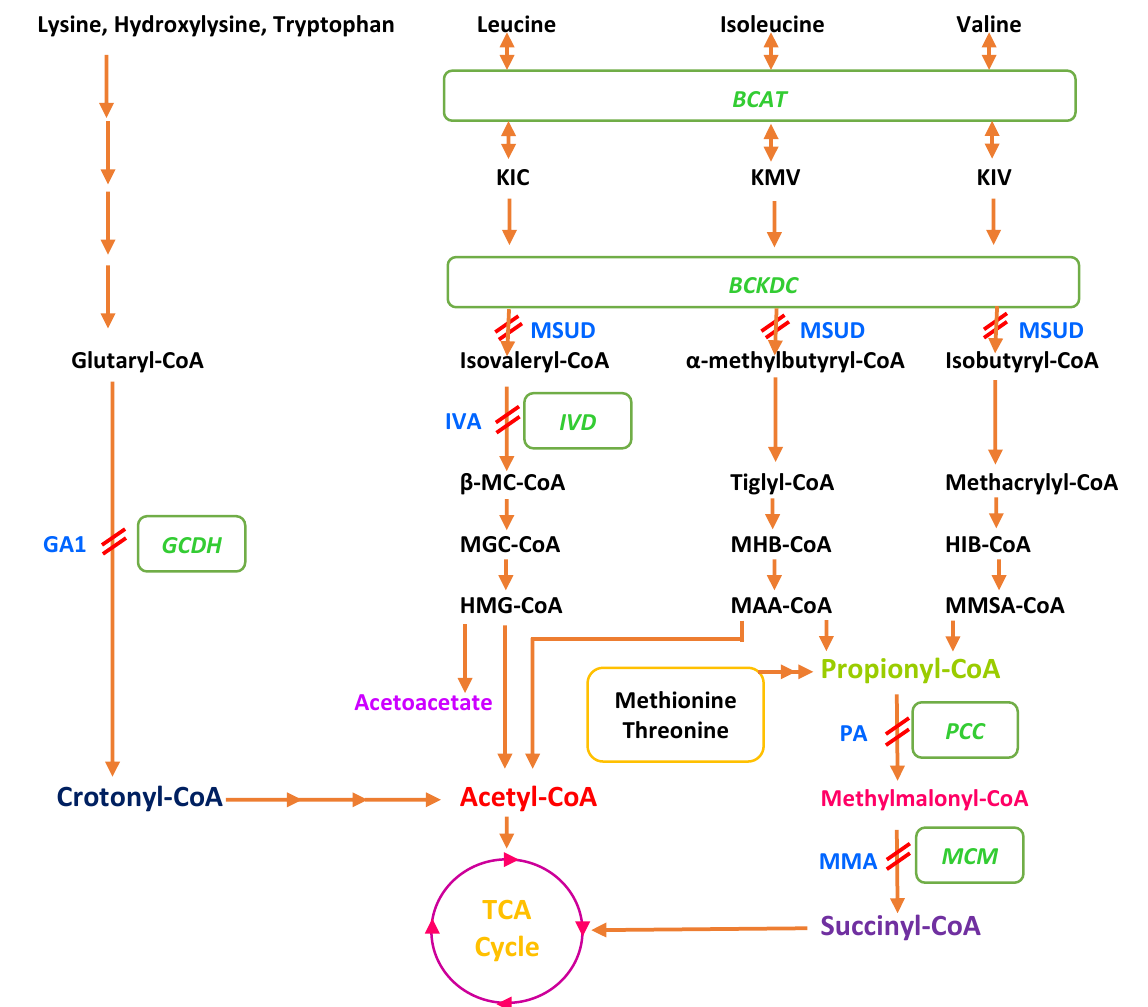
Figure 1. Main catabolic pathways of amino acids involved in organic aciduria. Abbreviations: